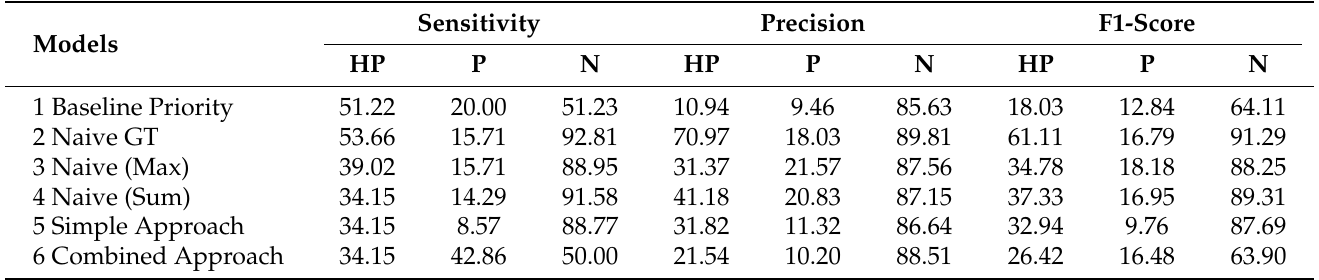
Table 12. Resulting metrics (%) of test set 1 of each final priority class for the different risk prioritiza- tion